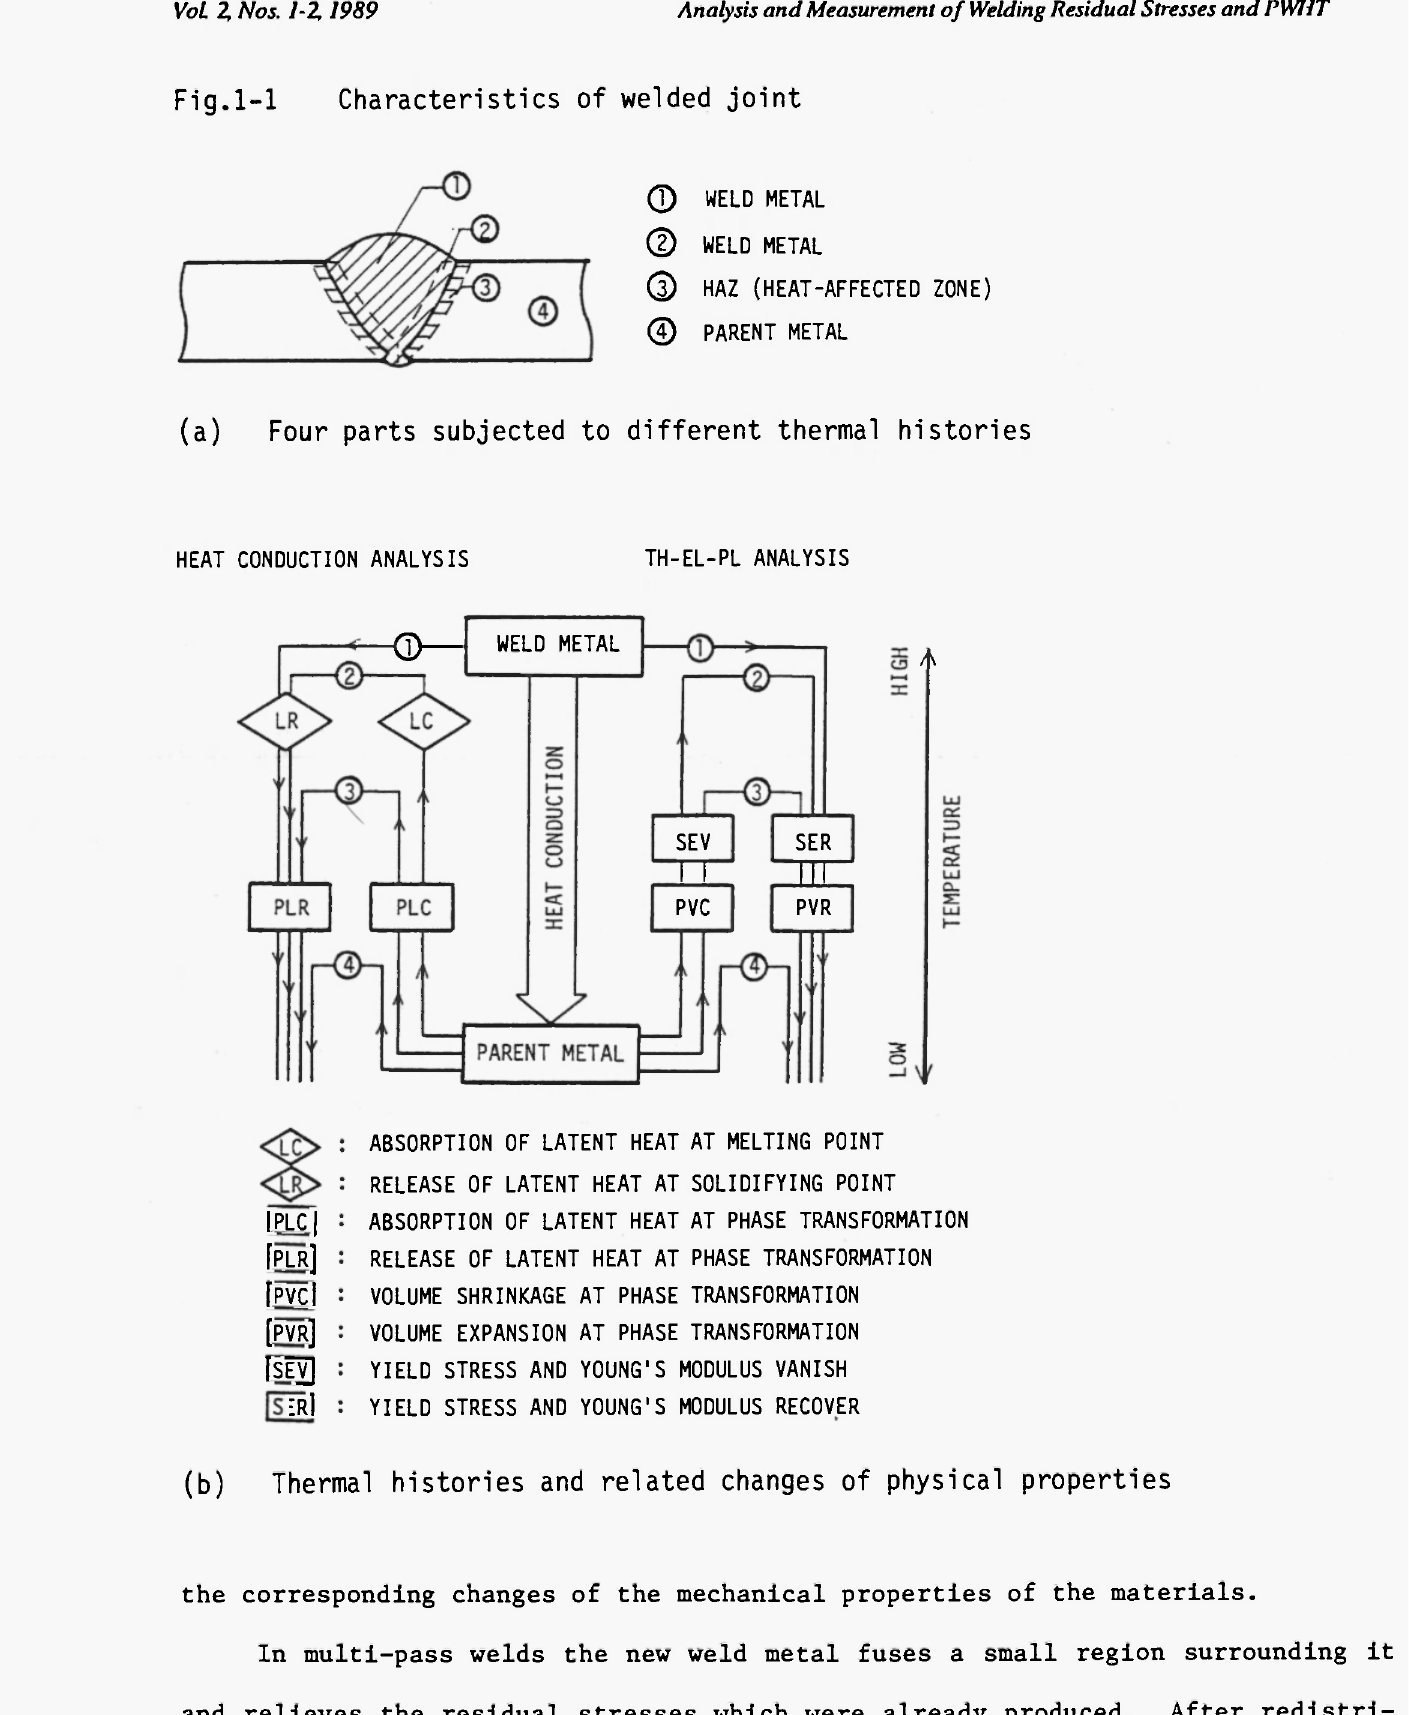
Fig.1-1 Characteristics of welded joint